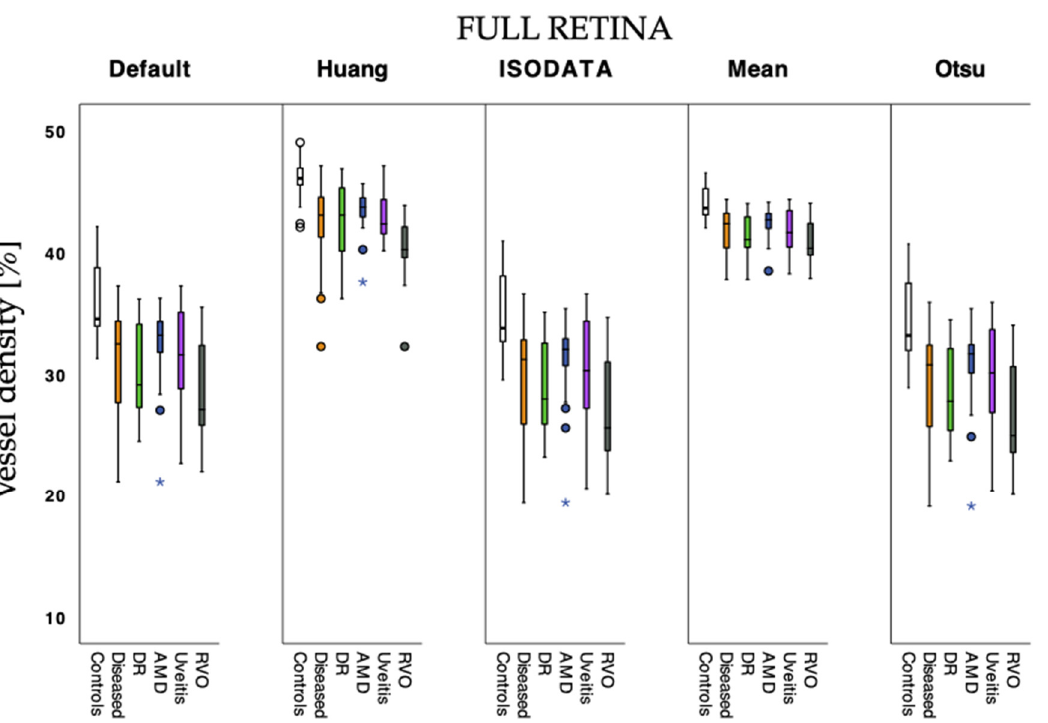
Figure 2. Vessel density values calculated with the tested algorithms for control and diseased eyes in full retina angiograms. Subgroups of diabetic retinopathy (DR), age-related macular degeneration (AMD), uveitis, and retinal vein occlusion (RVO) were also considered. Circles: outliers of 1.5 times the interquartile range of quartile 1 or quartile 3; stars: extreme outliers of 2.5 times the interquartile range of quartile 1 or quartile 3, respectively.